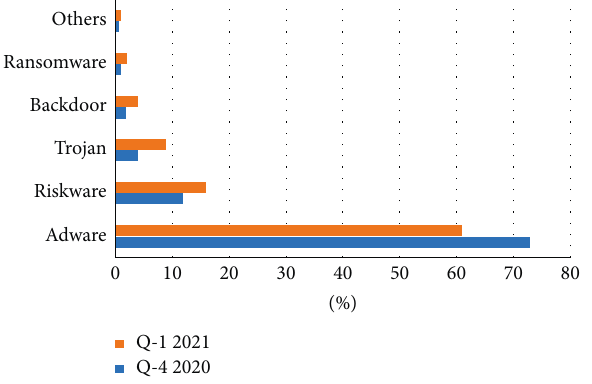
Figure 1: Android malware